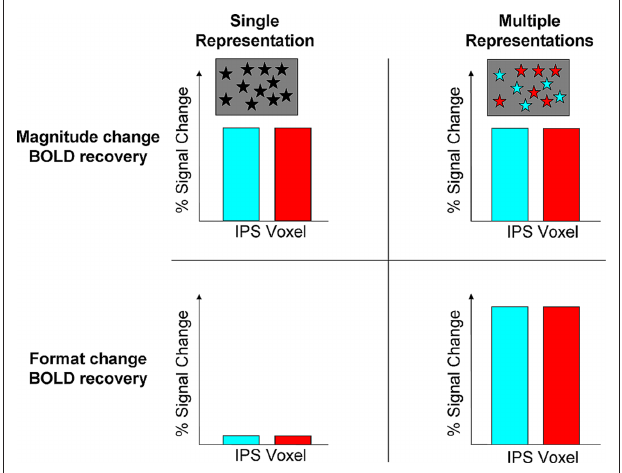
Figure 2 | Predictions of the recovery for magnitude and format change by the abstract and multiple representations. In this 2 × 2 matrix, the recovery for magnitude change is predicted to be similar for both hypotheses. This can be due to a single abstract representation in an IPS voxel (black asterisks), or because of multiple but overlapped representations due to developmental principles of human brain organization [turquoise (digits) and red (dots) asterisks]. Both hypotheses differ in the predictions for BOLD signal recovery during format change. The single representation predicts that although the format has been changed no recovery will be obtained as the same quantity is being presented. In contrast, the multiple representations hypothesis posits that during format change a full recovery will be obtained in the same areas that showed recovery for magnitude change. This recovery should be comparable or even stronger, but not weaker, compared to magnitude change, as a new representation comes into play (e.g., separate neuronal substrates for dots and digits, e.g., for 6 dots vs. the digit 6). In contrast, compared to format change, the recovery for magnitude change is only partial as neurons for a given quantity also code other similar magnitudes to some degree (Nieder and Miller, 2003; Cohen Kadosh et